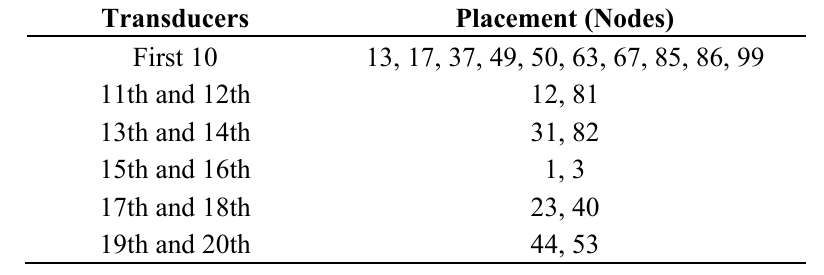
Table 3. Pressure transducer placement.